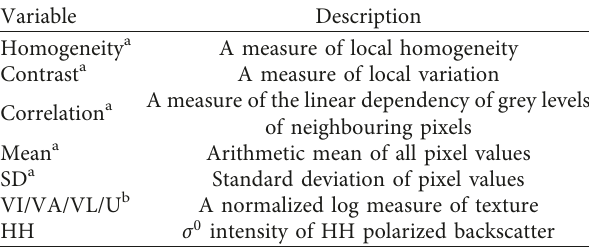
Table 2: Variables generated from SAR